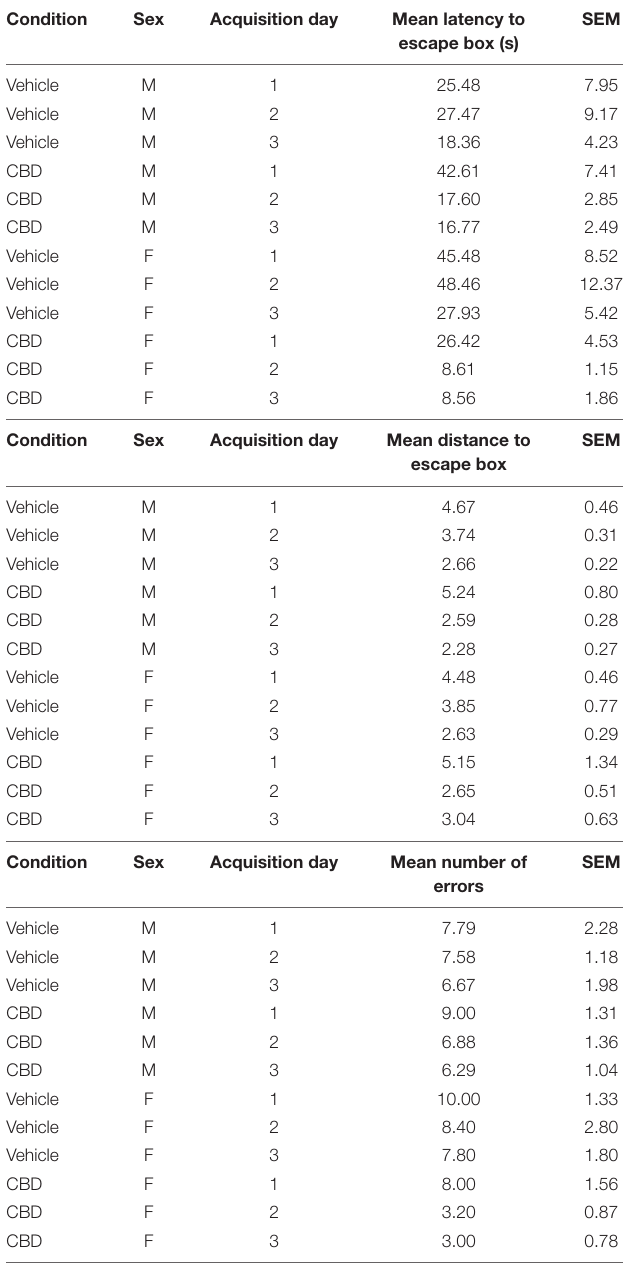
TABLE 1 | Descriptive statistics for the Barnes Maze acquisition